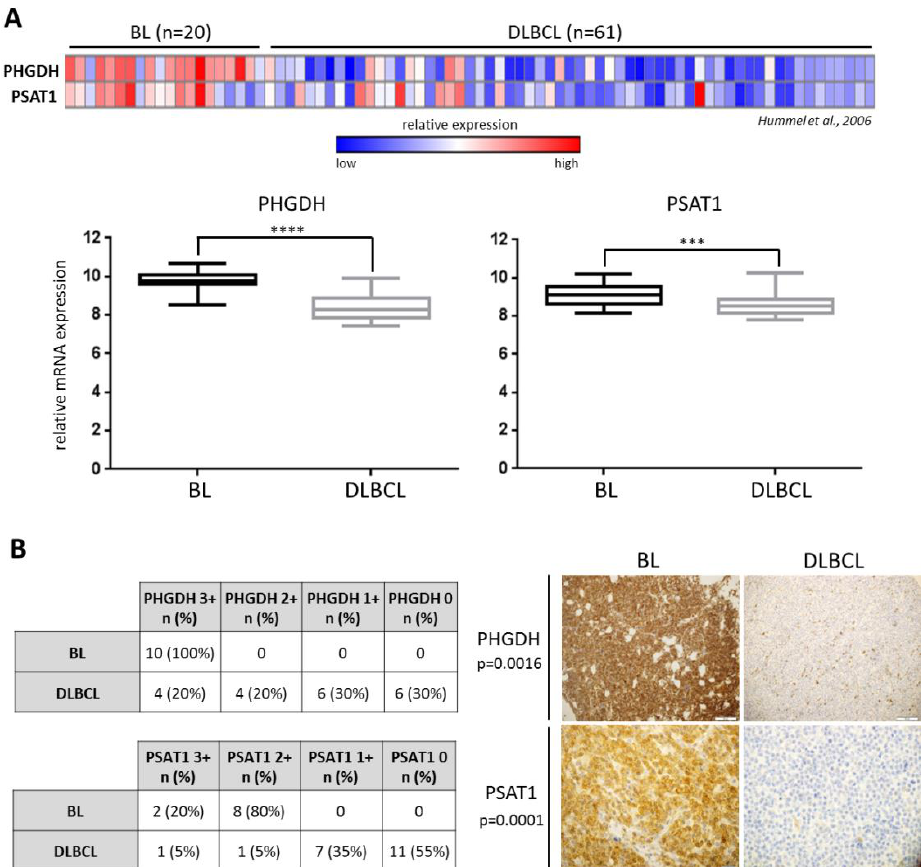
Figure 1. PHGDH and PSAT1 mRNA expression is significantly higher in Burkitt lymphoma (BL) than di ff use large B-cell lymphoma (DLBCL) primary cells. ( A ) Upper: Relative PHGDH and PSAT1 transcript abundance in primary tumor samples derived from 20 BL and 61 DLBCL patients. Each column represents a sample and each row refers to a gene probe; columns are ordered by tumor type (BL and DLBCL) as indicated. Color scale at the bottom indicates relative expression and standard deviations from the mean; n —number of patients. Lower: box plots illustrating di ff erences in PHGDH and PSAT1 expression between BL and DLBCL primary samples; the median expression is indicated by the horizontal line, bars denote ± 25–75 percentile and whiskers indicate the range. Statistical analysis was performed using the Mann–Whitney test, **** for p < 0.0001 and *** for p < 0.001. ( B ) The expression of PHGDH and PSAT1 proteins is significantly higher in BL than DLBCL primary tumors. The immunohistochemical analysis included a group of 10 BL patients and 20 DLBCLs. The scale from 3 + to 0 refers to the staining intensity, where 3 + refers to strong staining and 0 means no staining. Cases 3 + or 2 + in IHC were considered high-expressers, whereas cases 1 + or 0 were considered low expressers. Numbers / frequencies of high- versus low-expressers in BL vs. DLBCL were compared using the two-sided Fisher exact test. Representative cases of PHGDH +/ – and PSAT1 +/ – BLs and DLBCLs diagnostic formalin-fixed para ffi n-embedded slides are shown. Original magnification was × 40.